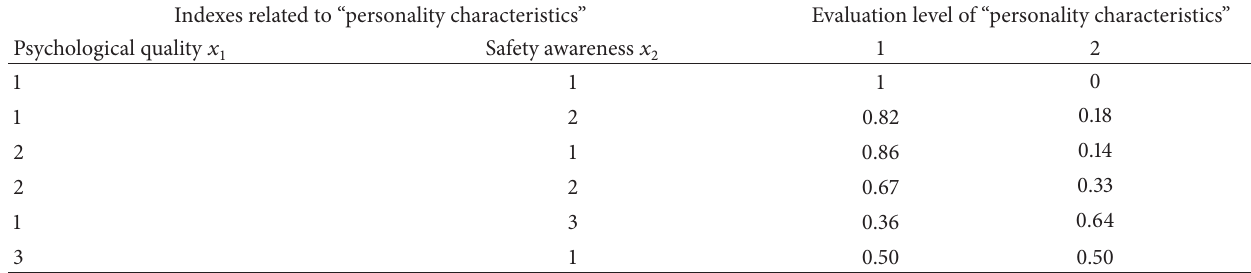
Table 4: Conditional probability of intermediate node (personality characteristics).